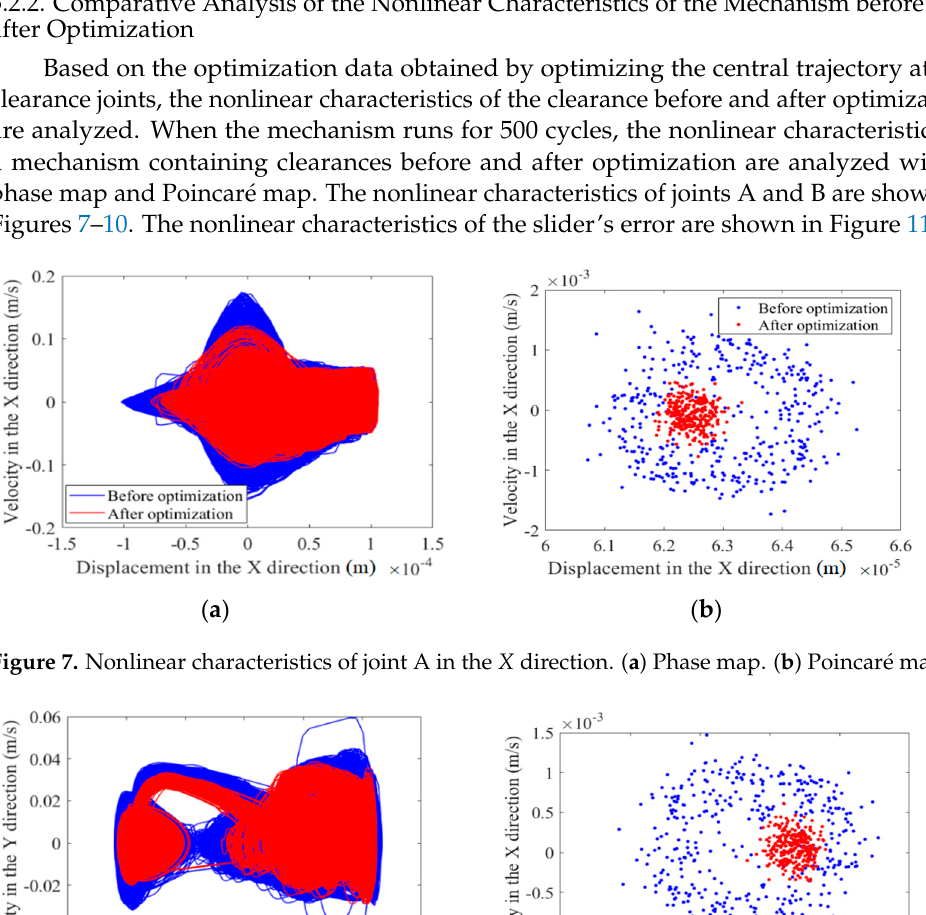
Figure 6. Dynamics response. ( a ) Displacement of the slider. ( b ) Velocity of the slider. ( c ) Acceleration of the slider. ( d ) Contact force of joint A. ( e ) Contact force of joint B. ( f ) Driving torque of crank 1. ( g ) Driving torque of crank 4. ( h ) Central trajectory of clearance A. ( i ) Central trajectory of clearance B.